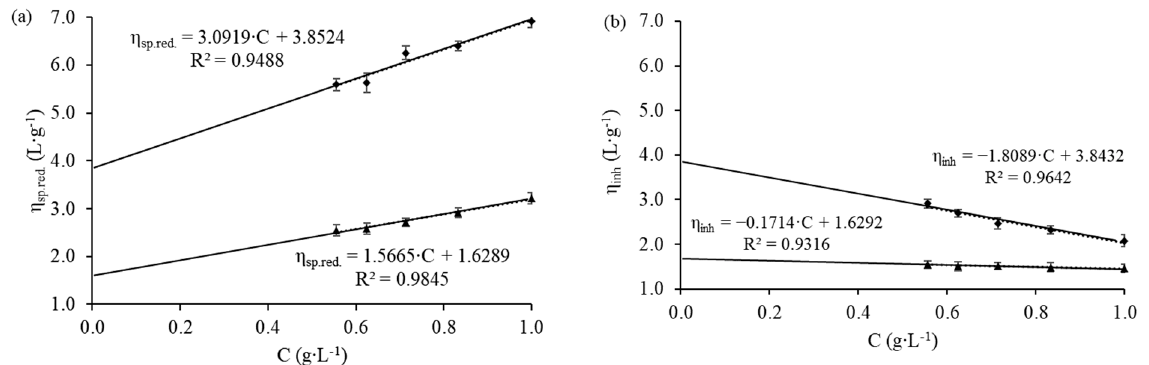
Figure 1. Reduced viscosity ( a ) and inherent viscosity ( b ) data for the buffer system of chitosan/acetic acid 0.20 M/sodium acetate 0.15 M ( ▲ ) and chitosan/acetic acid 1.00% v / v (0.17 M) ( ♦ ). The regressions, fitted to Huggins and Kraemer equations, yielded k H , k K , and k H + k K values of 0.590, − 0.065, and 0.525, respectively, for the chitosan/acetic acid 0.20 M/sodium acetate 0.15 M buffer system. On the other hand, the behavior of the chitosan/acetic acid 1.00% v / v was quite different; the calculated k H , k K , and k H + k K values were 0.209, − 0.122, and 0.087,